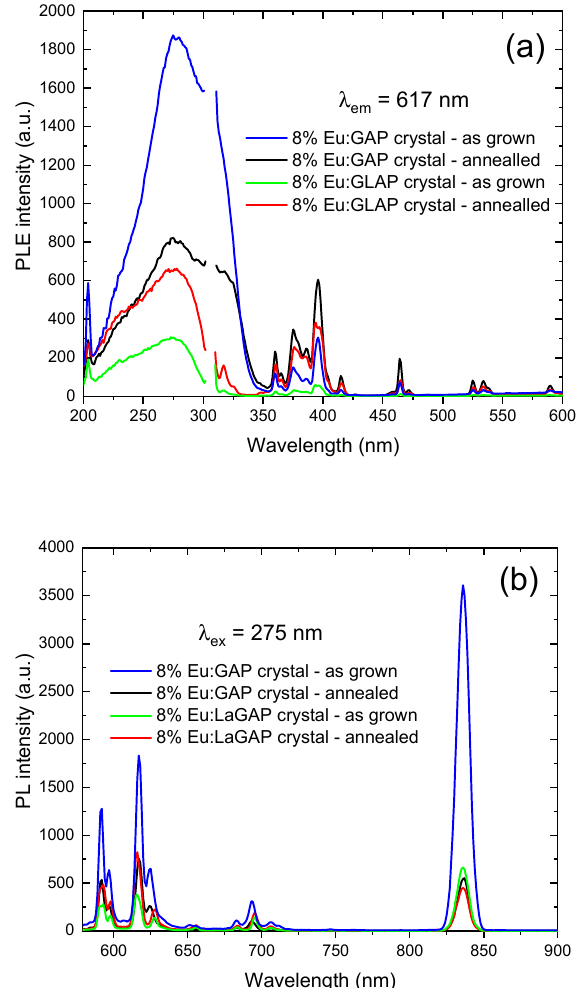
Figure 5. Photoluminescence spectra of the as-grown Eu:GAP and Eu:GLAP crystals; ( a ) PLE λ em = 617 nm; ( b ) PL λ ex = 275 nm.